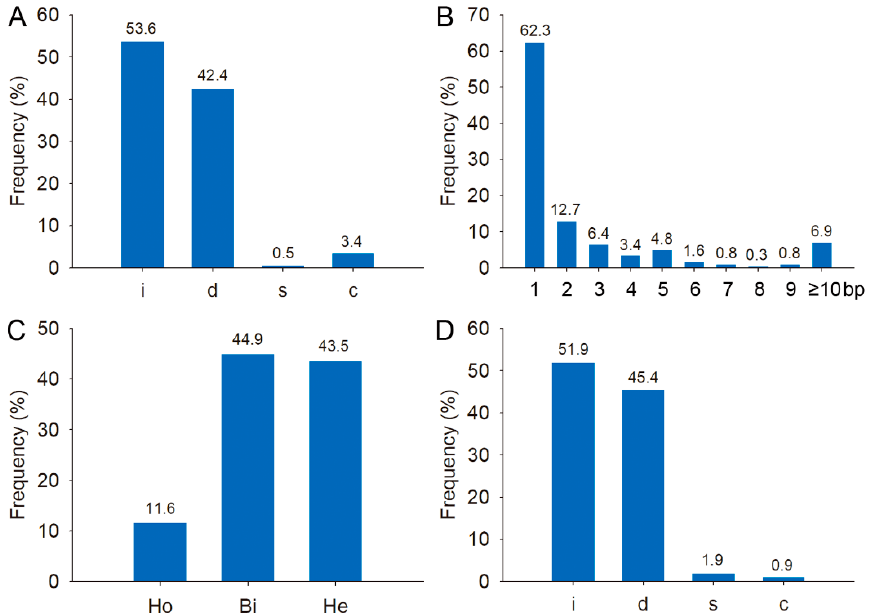
Figure 1. Characterization of on-target and off-target mutations. ( A ) Frequencies of different types of on-target mutations. ( B ) Frequencies of different lengths of on-target mutations. ( C ) Zygosity of off-target mutations. ( D ) Types of off-target mutations. Legend: i, insertion; d, deletion; s, substitution; c, combined mutation; Ho, homozygote; Bi, bi-allele; He, heterozygote.